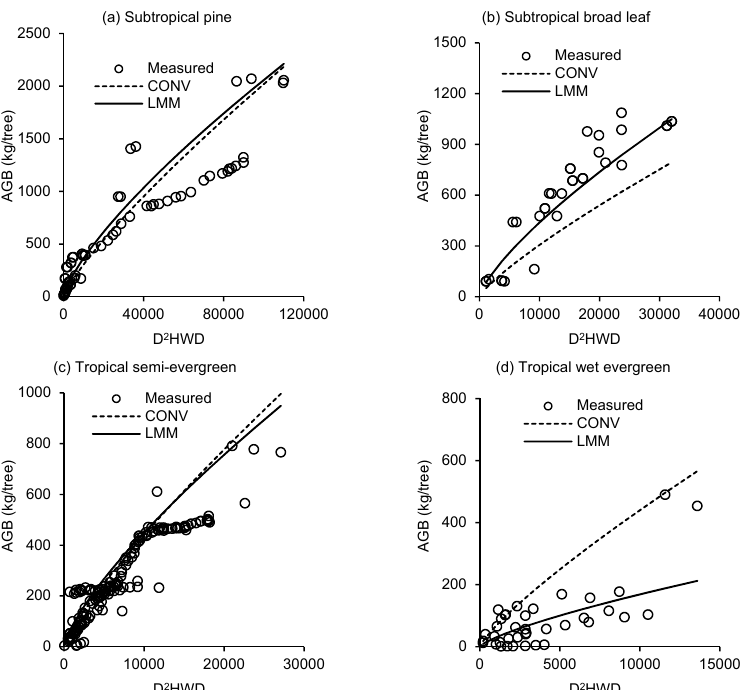
Figure 2. The observed AGB (open circles) and fitted lines for the four forest types produced using the highest rated model (Model 3) in the arithmetic domain. The dashed fitted lines represent predictions produced using the conventional (CONV) method, while the smooth lines represent predictions produced using the LMM procedure.